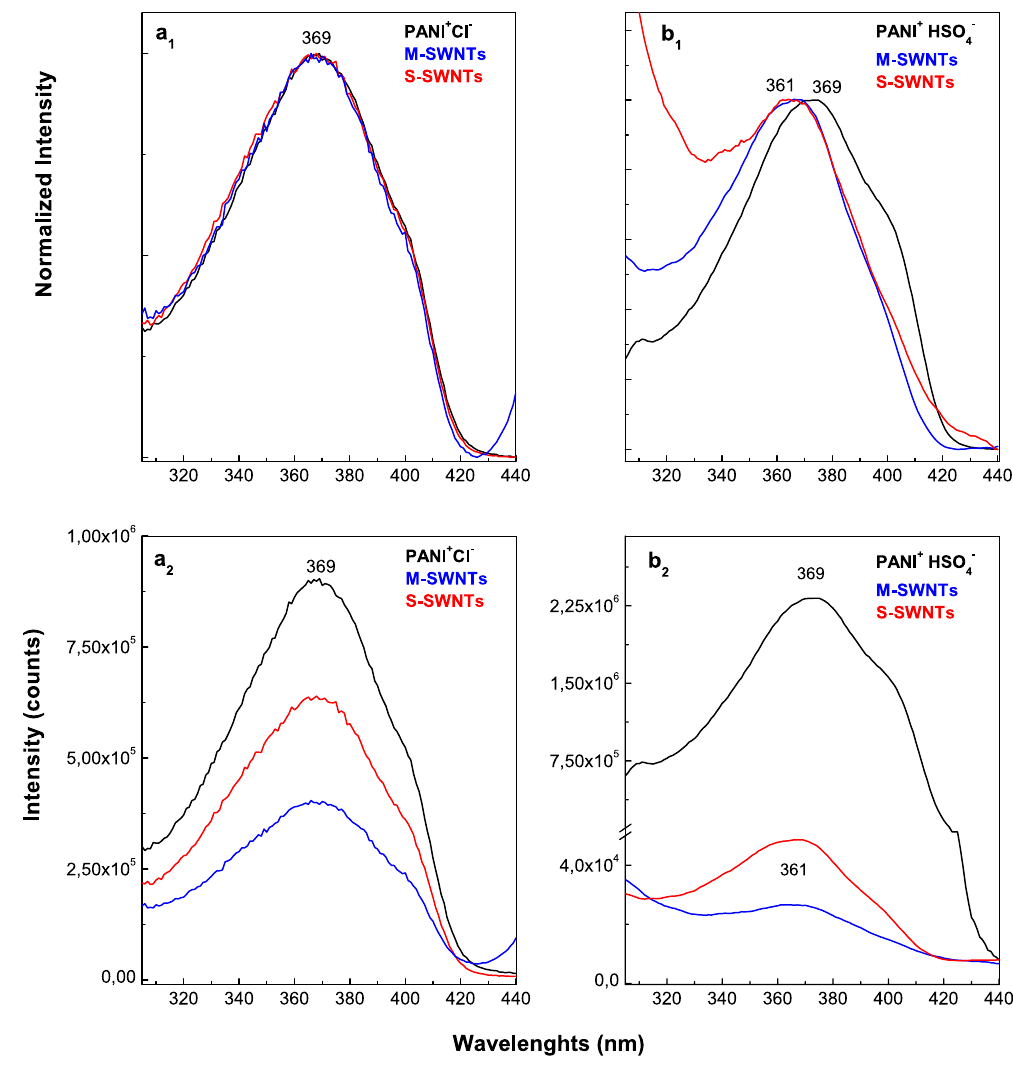
Figure 8. The PL excitation spectra of: PANI doped with Cl − ions (black curves in a 1 , a 2 ) and PANI doped with HSO 4 − ions (black curves in b 1 , b 2 ), the S-SWNTs/PANI doped with HSO 4 − ions (red curves in b 1 , b 2 ) and S-SWNTs/PANI doped with Cl − composites (red curves in a 1 , a 2 ) and (iii) the M-SWNTs/PANI doped with HSO 4 − ions (blue curves in b 1 , b 2 ) and M-SWNTs/ PANI doped with Cl − ions composites (blue curves in a 1 , a 2 ). All spectra were recorded at the emission wavelength of 460